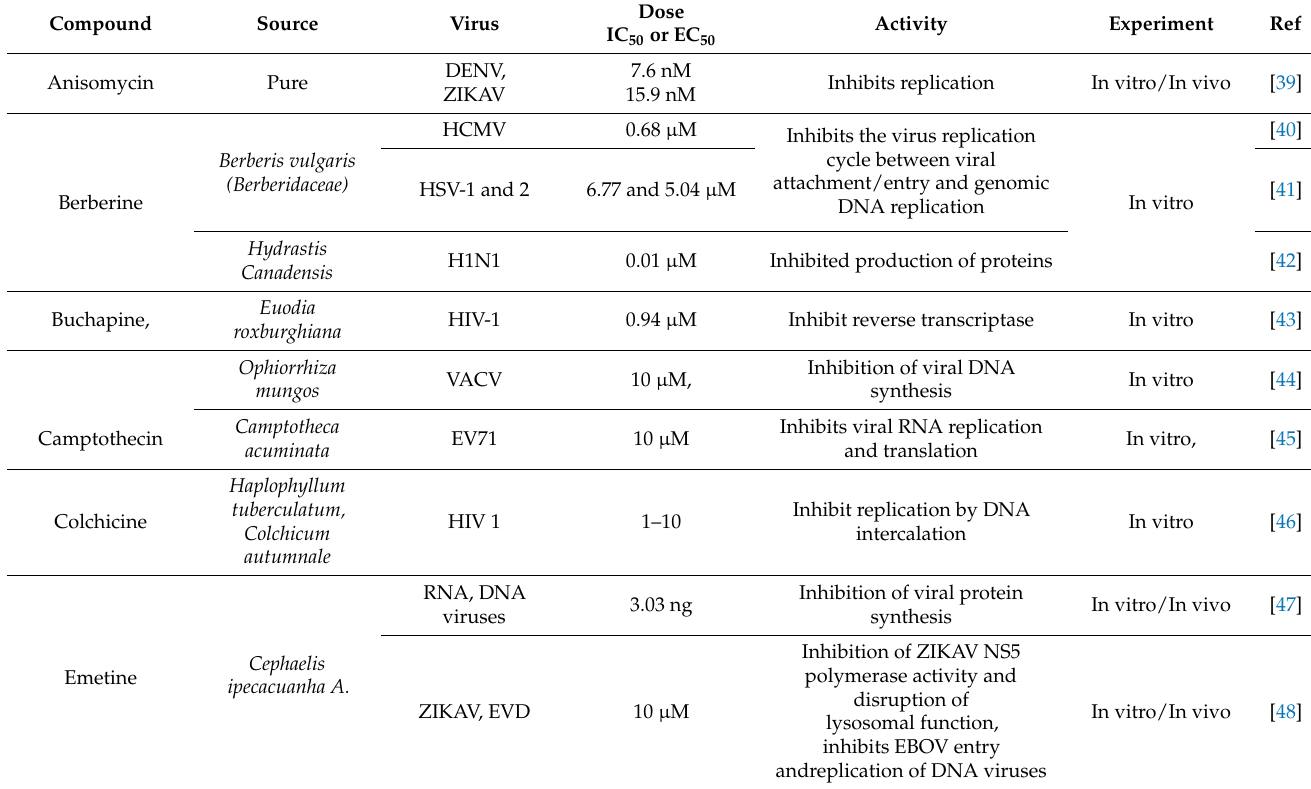
Table 1. Antiviral activities of